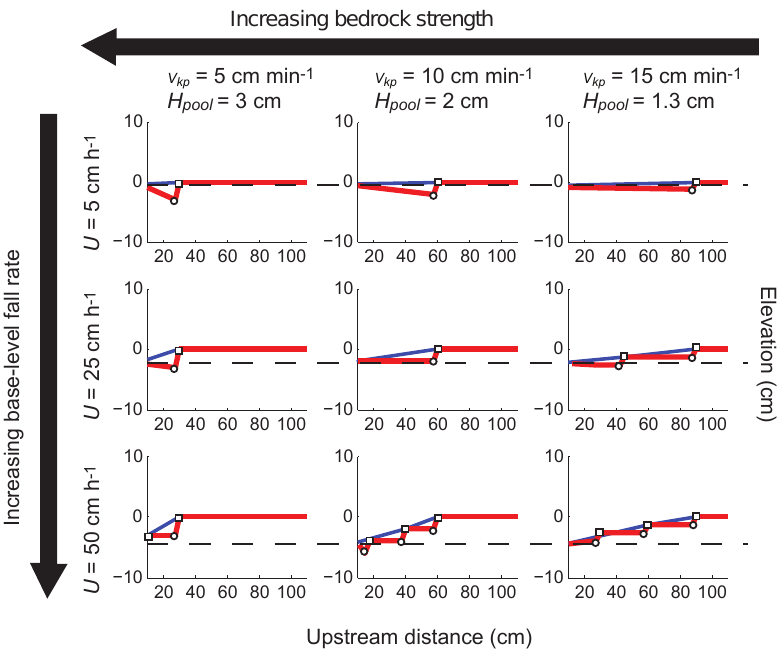
Figure 10. Snapshots of knickpoint migration calculated using Eqs. (4), (7) and (8). Each snapshot represents a simulation with a different set of parameters ( U , V kp , H p ) stopped after 6min of runtime. The bedrock surface (red line) is simulated by tracking the positions of the knickpoint (white squares) and the bottom of their associated plunge pool (white circles). The alluvium surface (blue line) is shown for comparison with the experiments. The bedrock surface initial elevation is set to zero. The first knickpoint is assumed to retreat instantaneously at a velocity V kp . The base-level falls at a rate U . A new knickpoint is generated each time the base level (shown by the black dashed line) reaches the depth of the plunge pool ( H p ) associated with the previous retreating knickpoint. For the sake of simplicity, no diffusive processes are considered in the simulations. The water discharge and horizontal distance between knickpoints and their plunge pool bottom (2cm) are assumed constant, while the velocity and height of unit knickpoints vary according to the main trend observed in the experiments (Table 1). The simulations are varying vertically as a function of base-level fall rate and horizontally as a function of substrate strength. This controls two parameters: when it is high, V kp is low and H p is deep, while when it is low, V kp is high and H p is shallower (Table